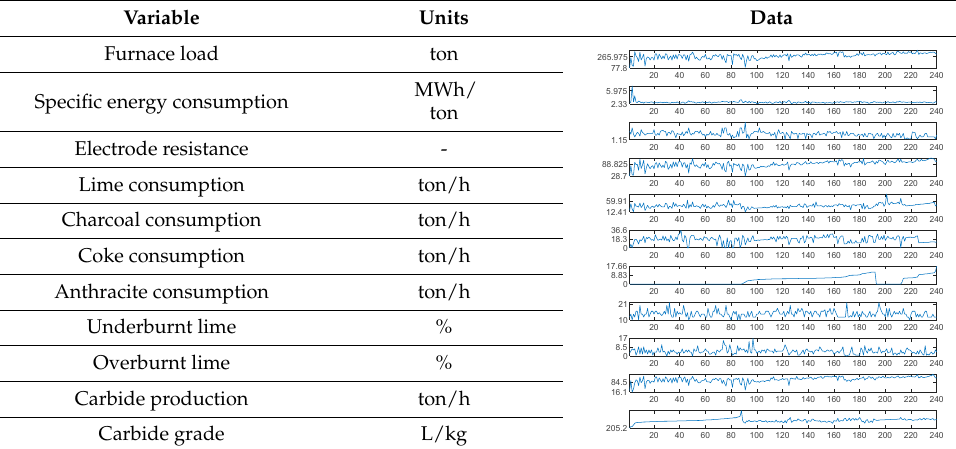
Table 1. Calcium carbide furnace data.